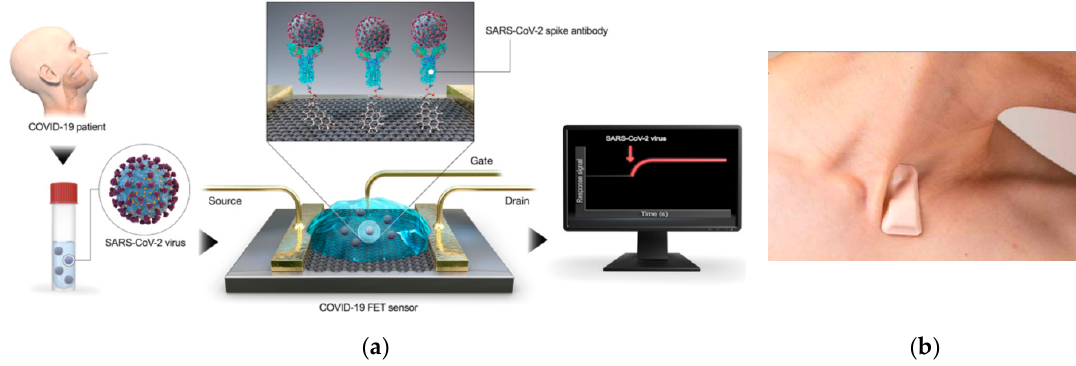
Figure 1. Some of the reported devices for the detection of SARS-CoV-2 using different technologies: ( a ) The graphene-FET based biosensor reported in [2] for the detection of SARS-CoV-2 spike protein and SARS-CoV-2, ( b ) Wireless, soft, skin-interfaced sensor platform for mounting on the suprasternal notch and continuous tracking of key symptoms of the disease [16].